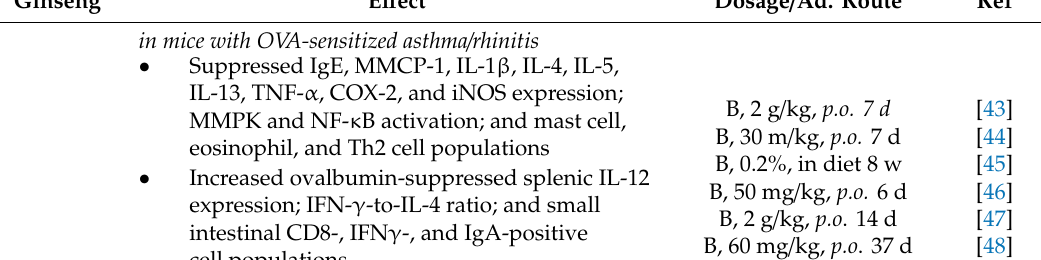
Table 1. Summary of ginseng extract e ff ects on allergic disorders. Ginseng E ff ect Dosage / Ad.